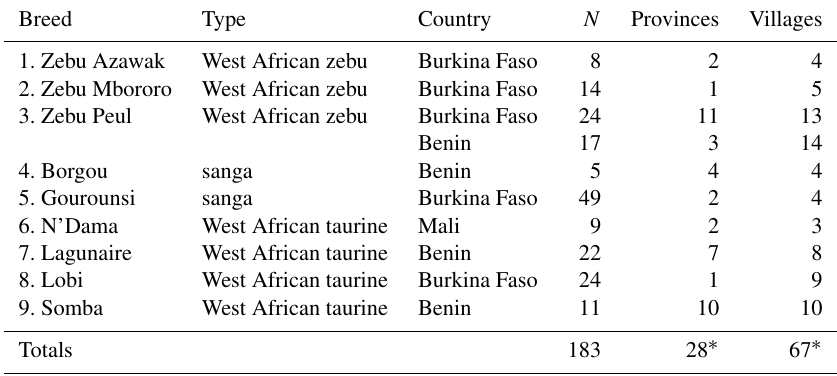
Table 1. Description of sampling. The following information is given per breed: type of cattle into which the breed is classified and countries in which the individuals of a given breed were sampled. Number of cattle ( N ), provinces and villages involved are provided as well. Breed Type Country N Provinces Villages West African